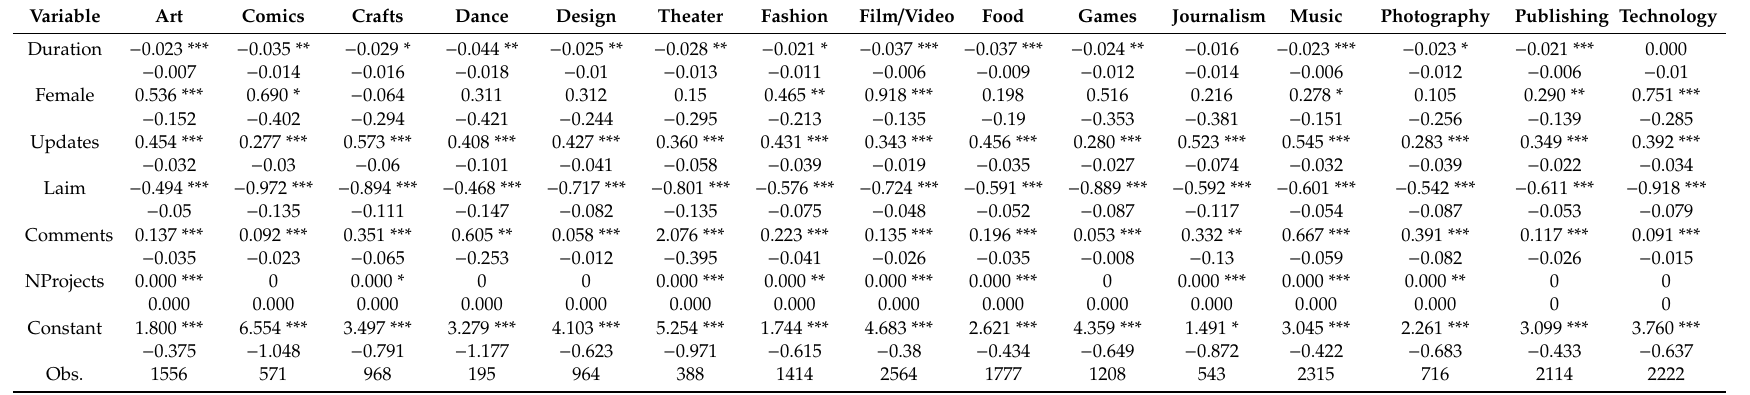
Table 15. Gender, success, and industry. This table reports the relationship between gender and success by industry. We control for di ff erent variables. Table 3 defines all the variables. * p < 0.1; ** p < 0.05; *** p <